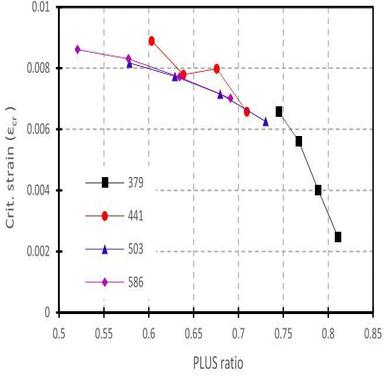
Plot of εcr vs. PLUS ratio for DT4 pipe (fp = 0.8).